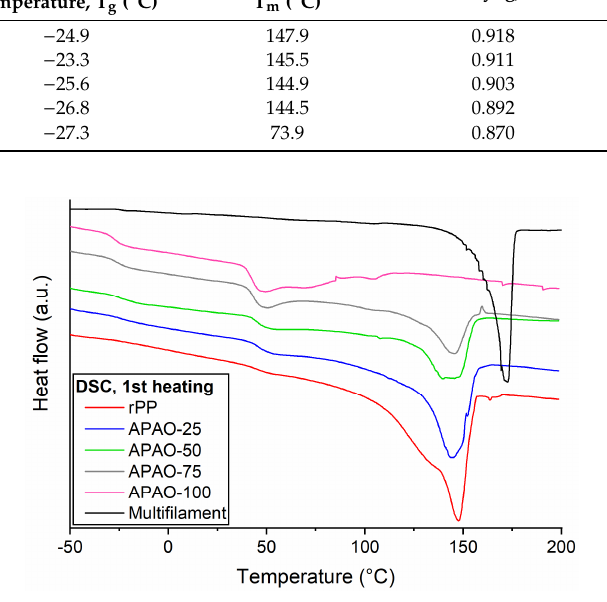
Figure 3. 1st DSC heating curves of the rPP/APAO blends.